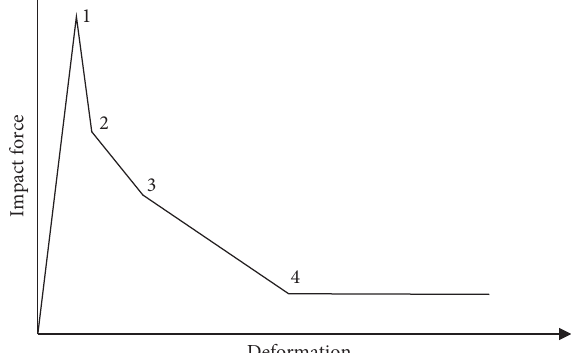
Figure 6: Simplified NSS.